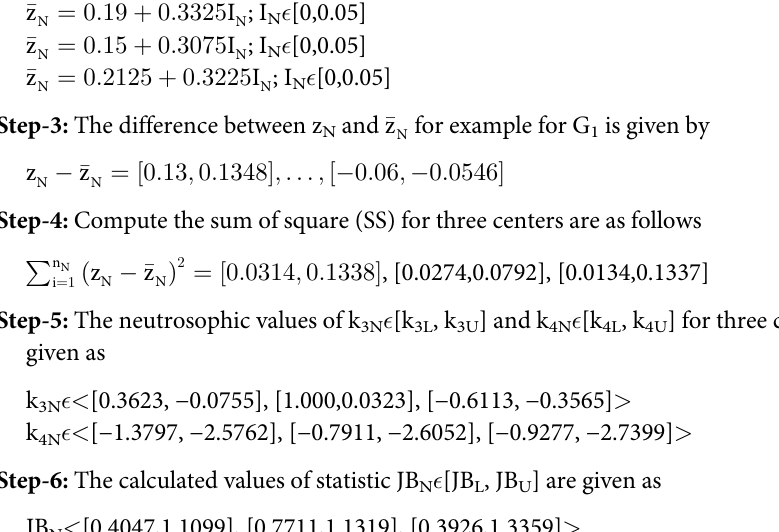
The value of the proposed JB test statistic is not much far away from zero, indicating that N the gold mines data follow a normal probability distribution with an indeterminacy level. The same can be verified by using the Chi-square distribution table in Step-7. Step-7: The table value for the level of significance 0.05 is 7.815. We note that JB are less than the tabulated value. Therefore, the null hypothesis is that data from three cen- ters are not significantly different from the neutrosophic normal distribution, and this deci- sion is the same as [47].